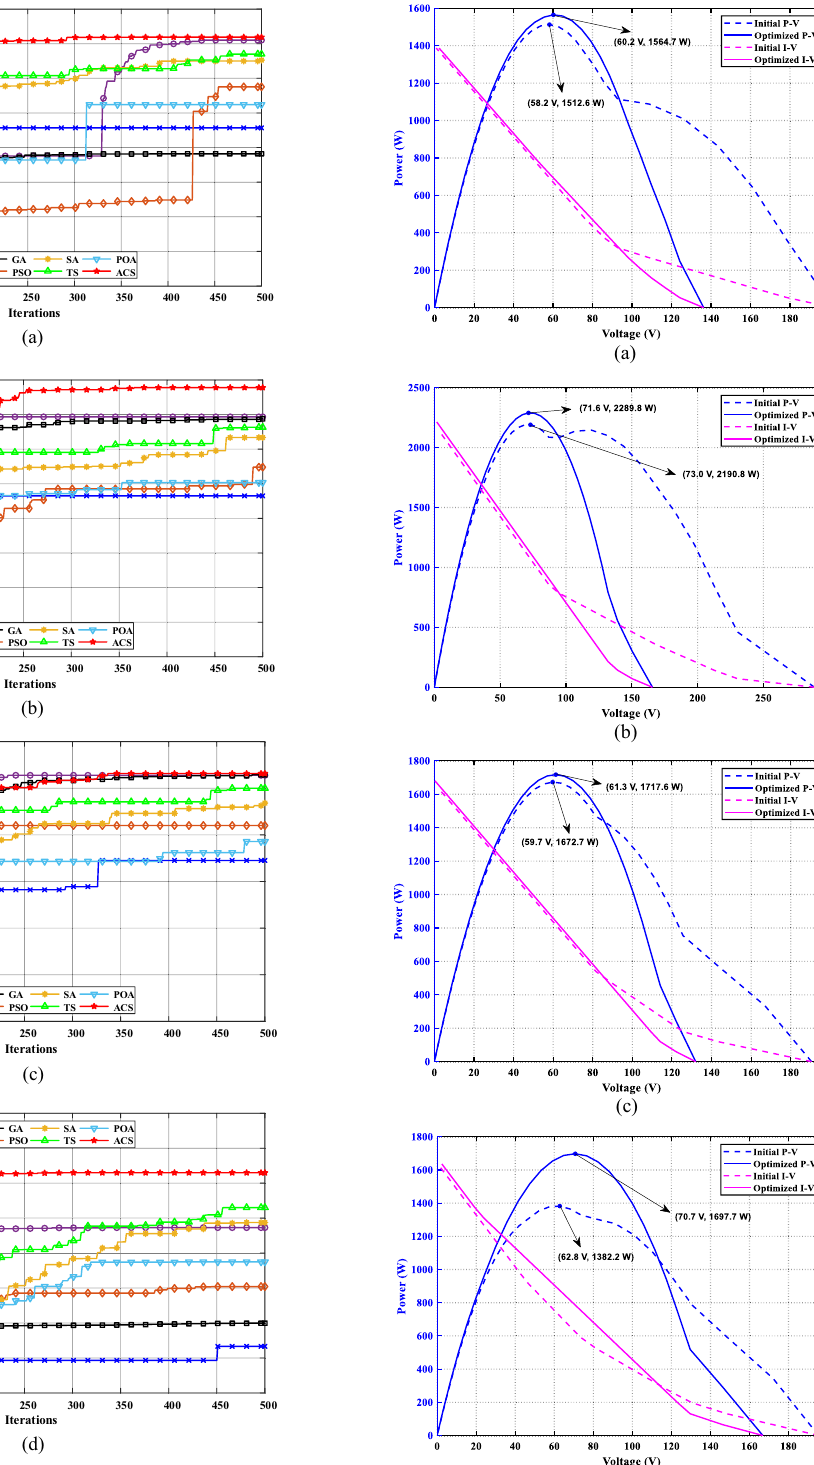
15) TEG system under four ×